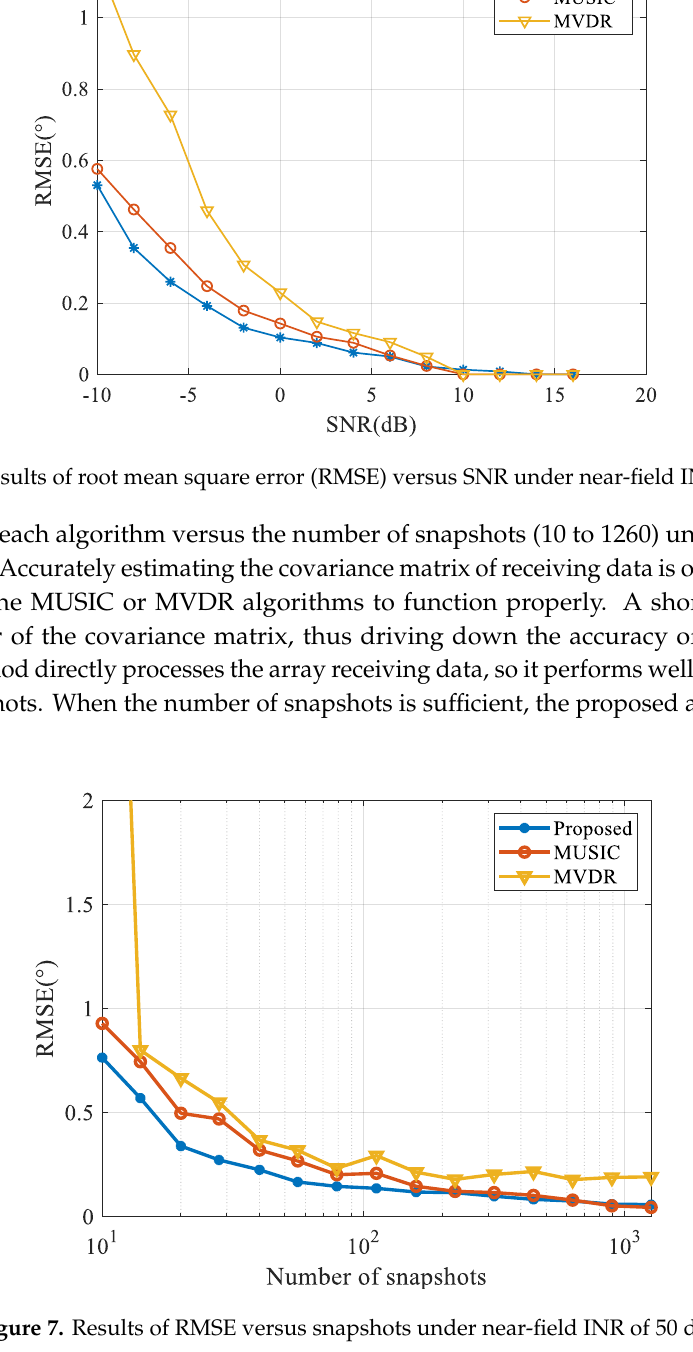
Figure 7. Results of RMSE versus snapshots under near-field INR of 50 dB.